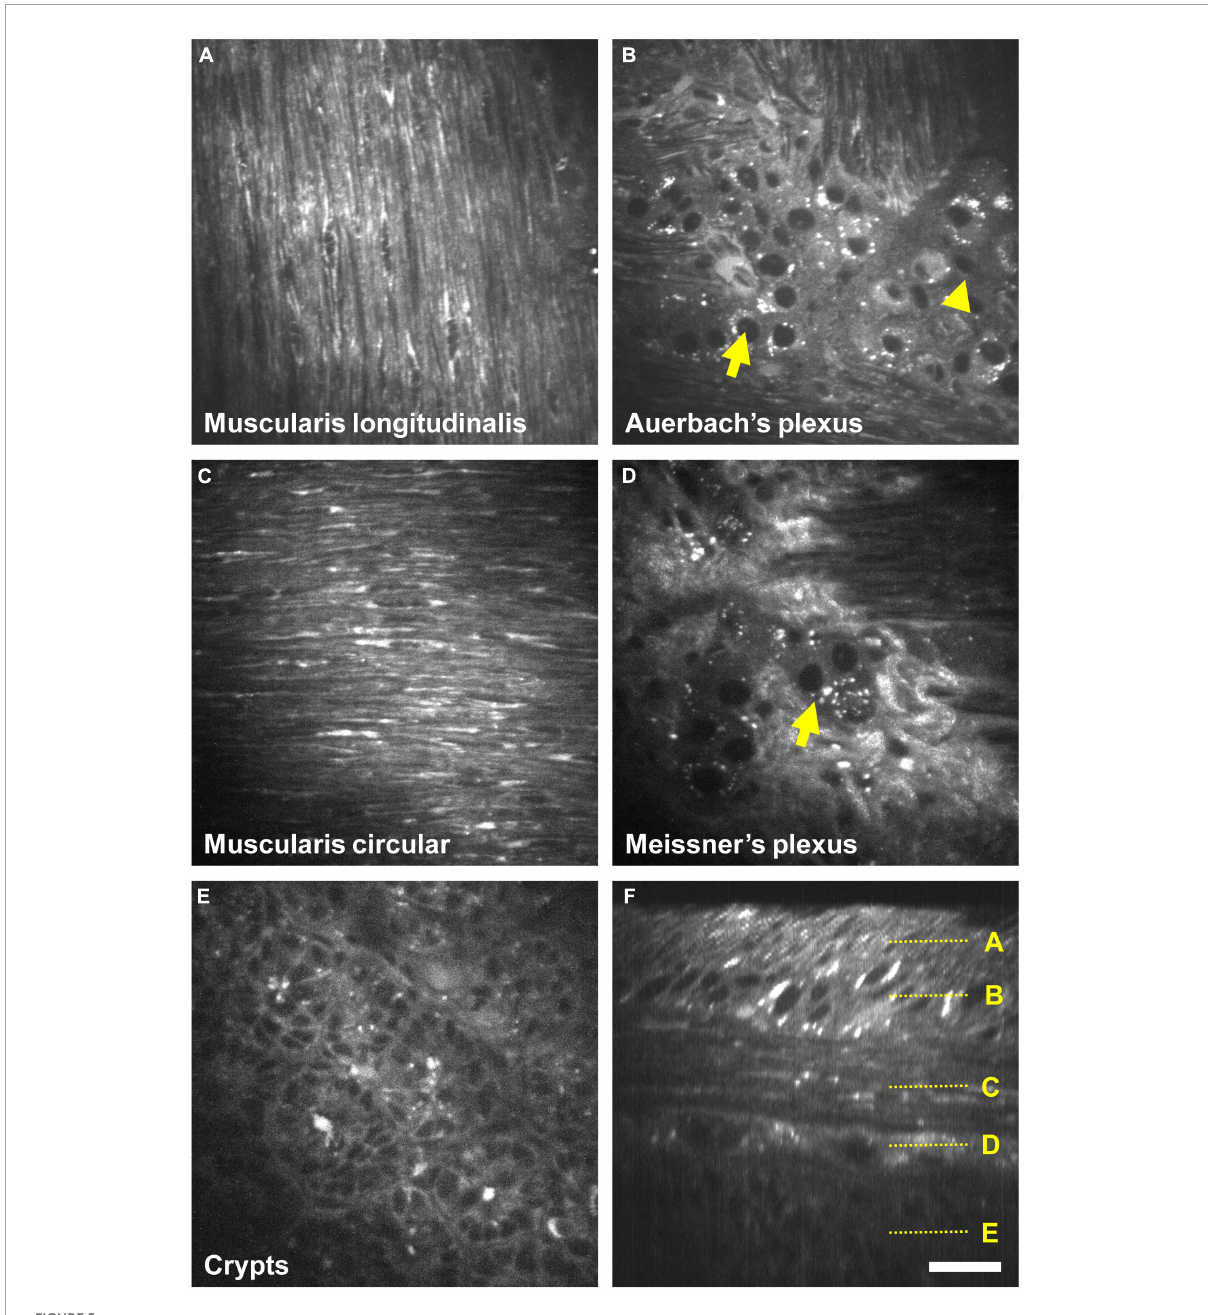
FIGURE5 Fast 3D two-photon (2P) imaging of the enteric nervous system (ENS) on the OASIS microscope. (A–E) Autofluorescence (AF) images taken upon 800 nm 2P excitation at different depths of the intestinal wall, starting from the muscularis longitudinalis down to the crypts (see also Supplementary Videos 1, 2 ). Arrows: neurons, arrowheads: enteric glia. (F) Orthogonal reconstruction based on a z- stack acquired with 1 µ m steps. Localizations of images (A–E) are depicted on the right. Scale-bar: 25 µ